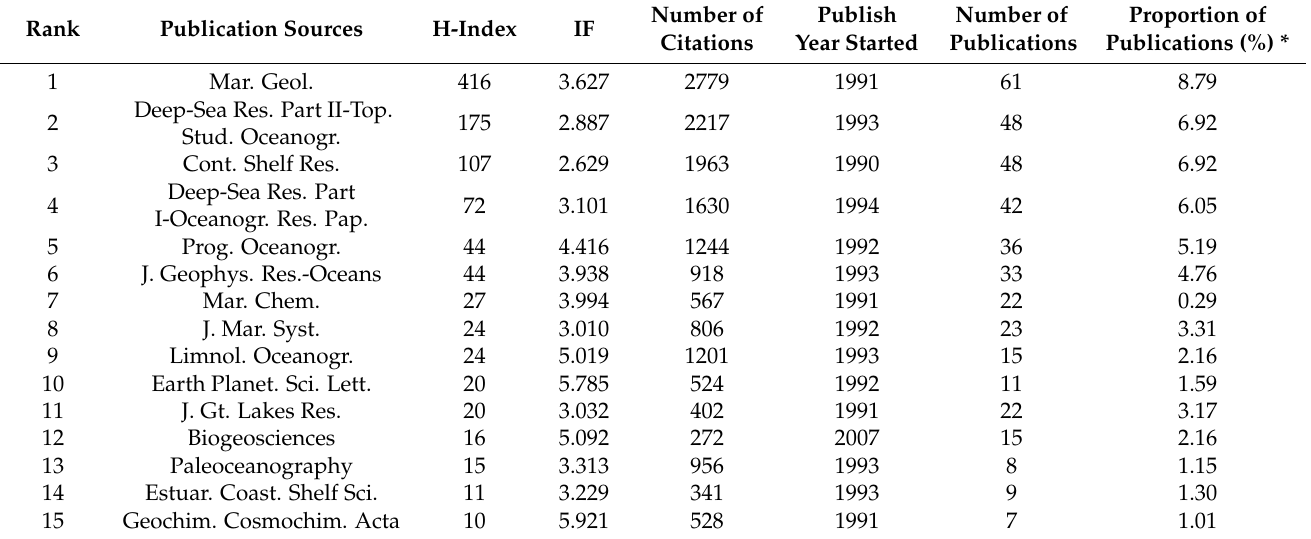
Table 3. Top 15 publication sources related to nepheloid layers with the highest H-index from 1990 to